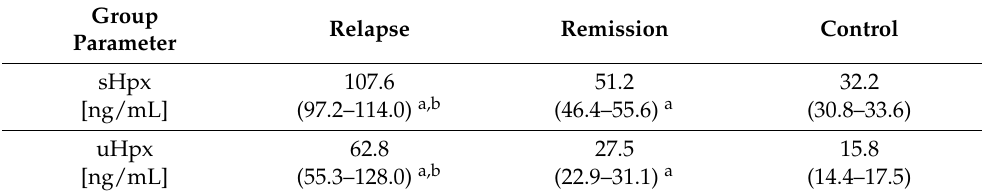
Table 2. Serum and urine Hpx levels in the whole group of INS children, depending on dis- ease clinical phase compared to the control group. Data are presented as median values and interquartile